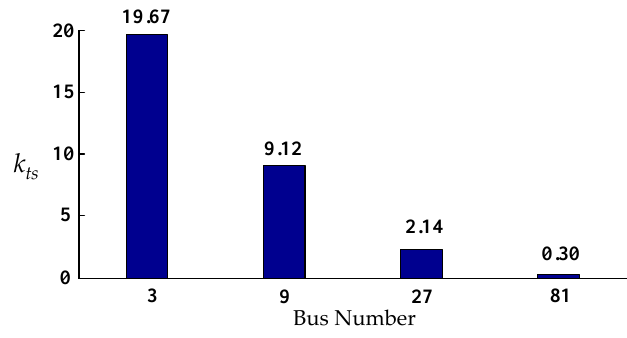
Figure 8. k ts corresponds to the change of bus number.